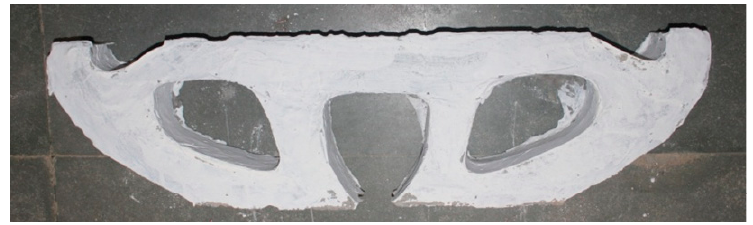
Figure 5. Minimum compliance of topology optimized HPB.